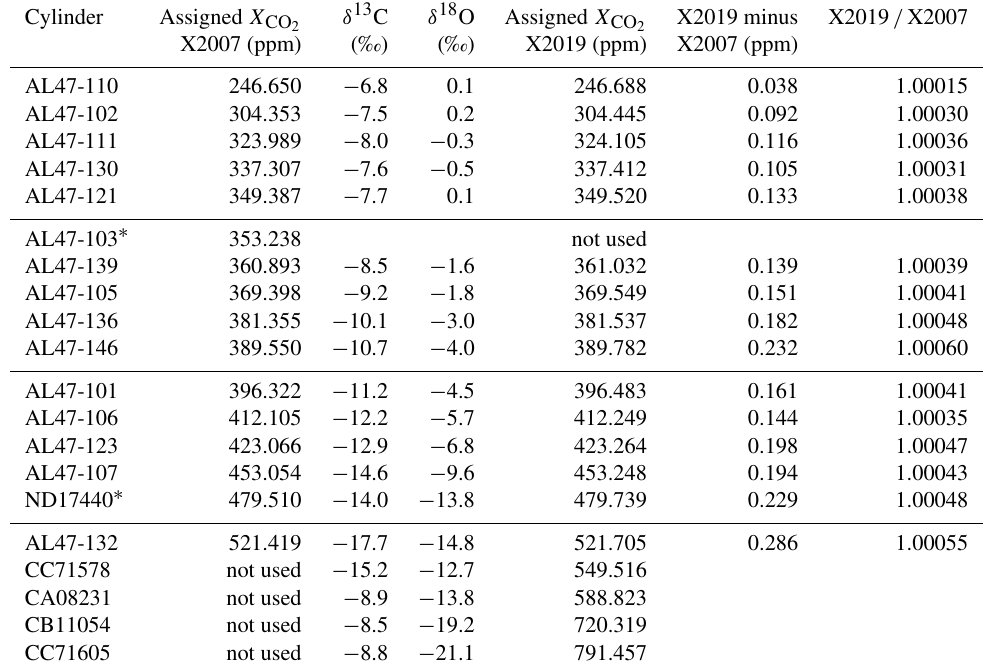
Table 2. WMO primary standard assignments on X2007 and X2019 scales. Assignments were determined following analysis and residual correction by NDIR (X2007) and laser spectroscopy (X2019). The average ratio of primary standards on scales X2019 / X2007 is 1.00040, with a standard deviation of 0.00011.